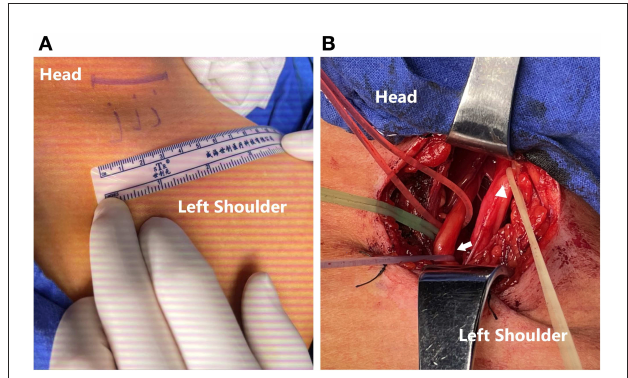
FIGURE1 (A) An incision for around 4 cm-length centered over the clavicle. (B) Exploration of the brachial plexus and an intraoperative EMG test to reconfirm that the C5 root (yellow line; triangle) had been avulsed and the C7 root (red line), especially PDIC7 (purple line; arrow) had normal electrophysiological